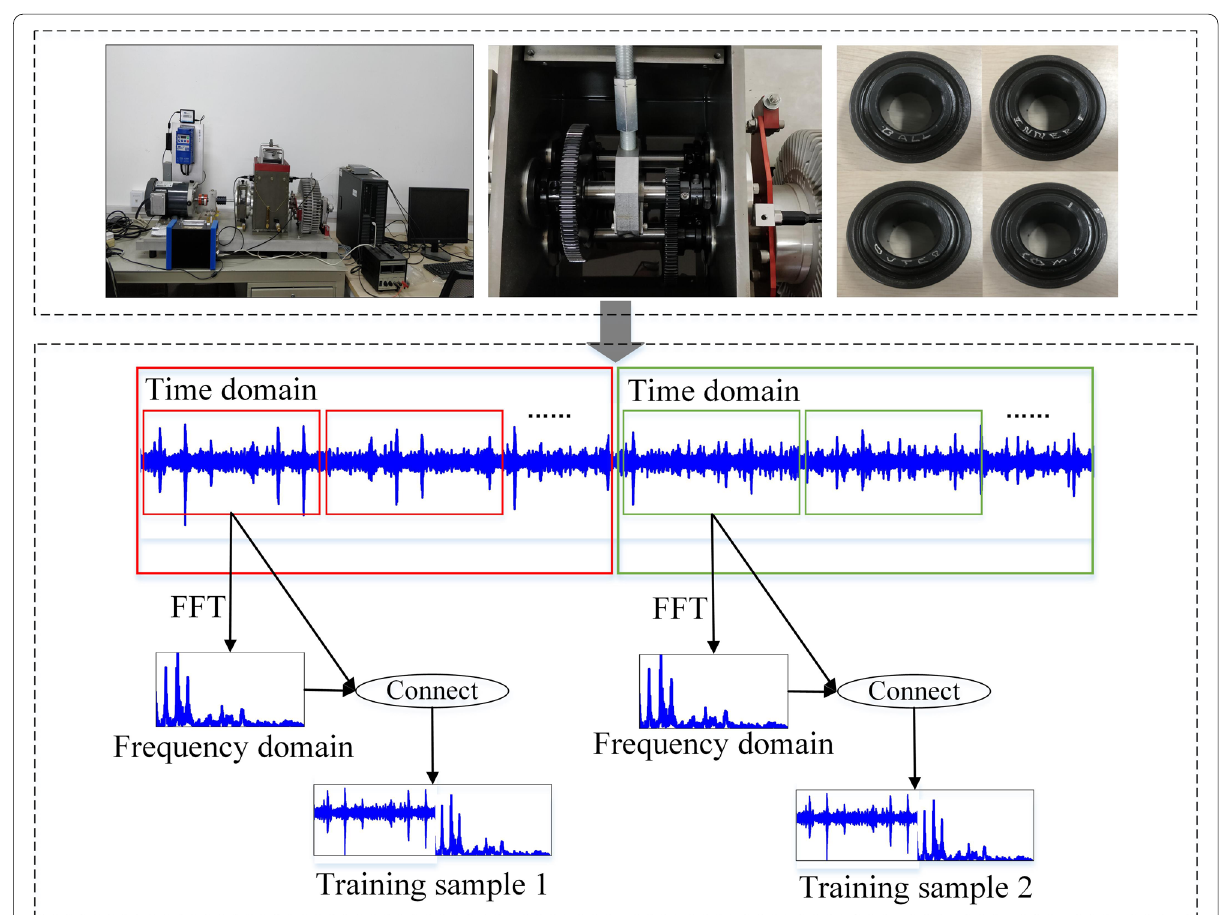
Fig. 4 Data preprocessing steps. In this study, an acceleration sensor was used to collect the vibration signals of rolling bearings from the fault diagnosis experiment platform. The first half of the collected signal was used as the training set (red box in Fig. 4), and the second half was used as the testing set (green box in Fig.